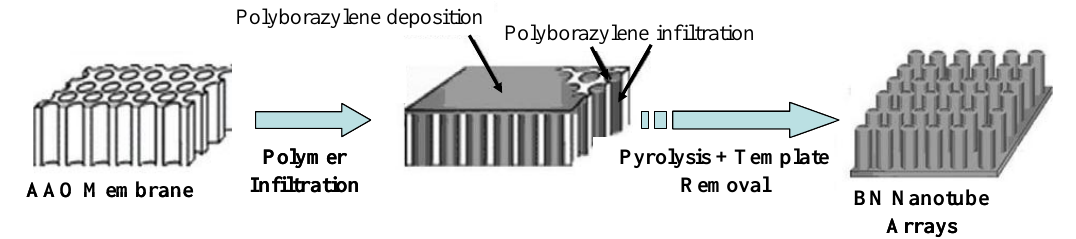
Figure 5. Polymer nanocasting leading to BN nanotube